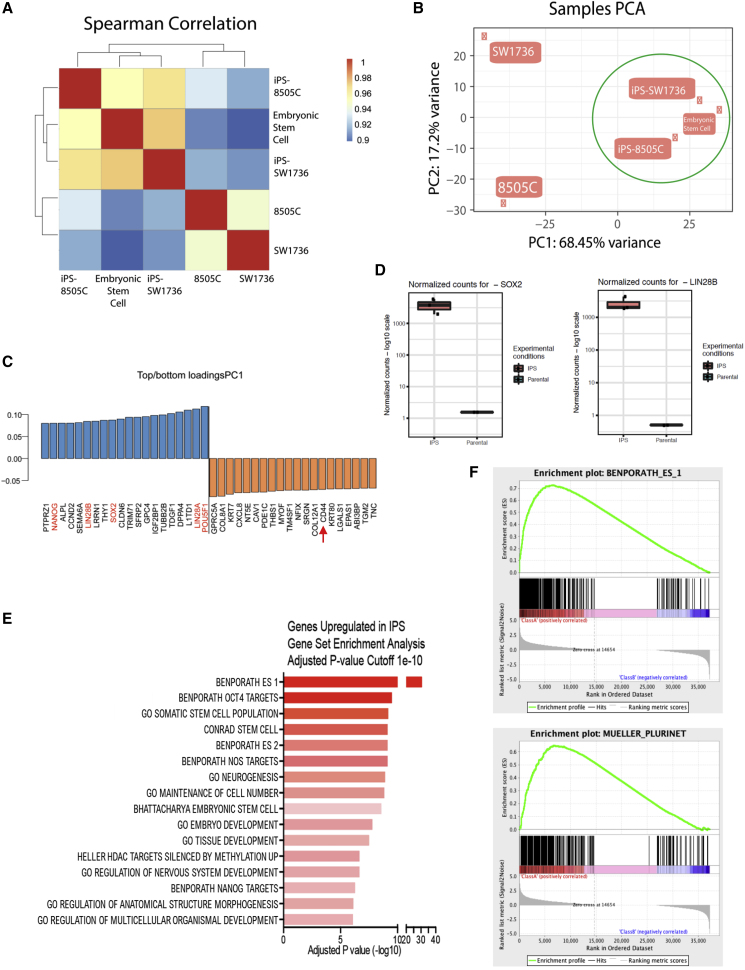
Transcriptional Programs Distinguish the Cancer-Derived hiPSCs from Their Respective Starting Cancer Cells; They Hew Closer to Gold Standard hESCs than to Their Neoplastic Parental Cells(A) Spearman correlation heatmap showing correlation between samples based on global transcriptional profiling by RNA-seq. hiPSCs (iPS-8505C and iPS-SW1736) derived from each cancer cell line (8505C and SW1736, respectively) were both better correlated with hESCs than with their starting cancer cells.(B) Principal component analysis (PCA) of global transcriptional profiling by RNA-seq. hiPSCs derived from each cancer cell line were in the same group with hESCs (green circle) (principal component 1 [PC1]); the two cancer cell lines segregated to a different group.(C) Top genes for PC1 shown in (B). Genes shown in blue are positively correlated with PC1, and contain many pluripotency genes (in red). Genes indicated in orange are negatively correlated with PC1 and, for example, contain a marker for cancer stem cells (CD44, red arrow).(D) Normalized transcript counts for the stemness genes SOX2 and LIN28B in the hiPSCs versus the parental cancer populations. Transcripts per million values from the RNA-seq data were compared with the mRNA expression of cancer cells before (parental) and after (hiPSC) induction of pluripotency. Sequencing reads were mapped to the genome using Salmon (Patro et al., 2017) and further processed using TXimport (Soneson et al., 2015) and DESEQ2 (Love et al., 2014) to generate normalized counts based on sequencing depth and gene length. As shown in this panel, SOX2 and LIN28B have elevated mRNA expression levels in the hiPSC group relative to their parental cancer group.(E) Gene set enrichment analysis for the top 100 genes upregulated in hiPSCs compared with parental populations at the mRNA level. The most upregulated pathways in the hiPSCs compared with the cancer parental cells were pathways associated with hESC pluripotency, stem cell maintenance, neurogenesis, embryo development, and tissue development.(F) Gene set enrichment analysis for the “BENPORATH ES 1” dataset (which includes genes overexpressed in hESCs [according to 5 or more out of 20 profiling studies]) (false discovery rate [FDR]-corrected p value <0.0001) and the “MUELLER PLURINET” dataset (which includes genes constituting the PluriNet protein-protein network shared by human pluripotent stem cells—hESCs, embryonical carcinomas, and hiPSCs) (FDR gene signatures). This analysis showed that the hiPSCs (group on the left side of the graph) were enriched in the two datasets while cancer cells (group on the right side of the graph) only expressed a few of the genes in the two datasets.